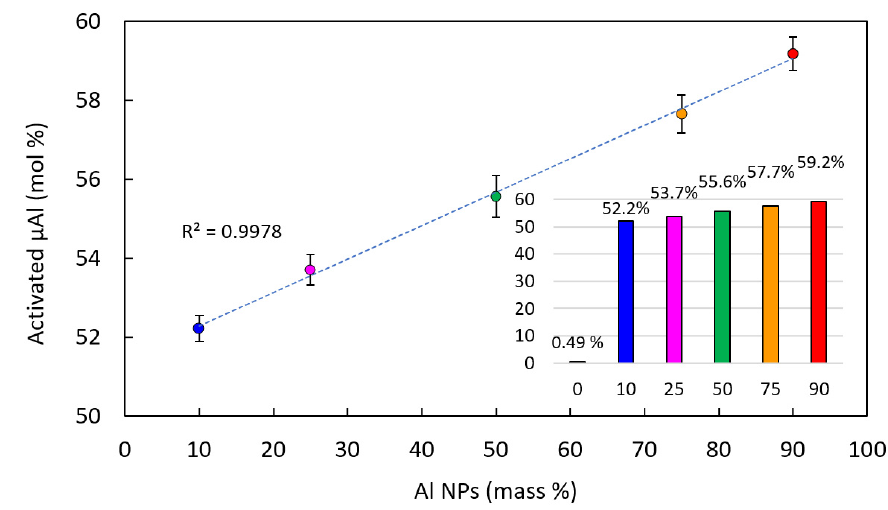
Figure 2. Activated μ Al (as defined in Equation (5)) versus mass % of Al NPs.